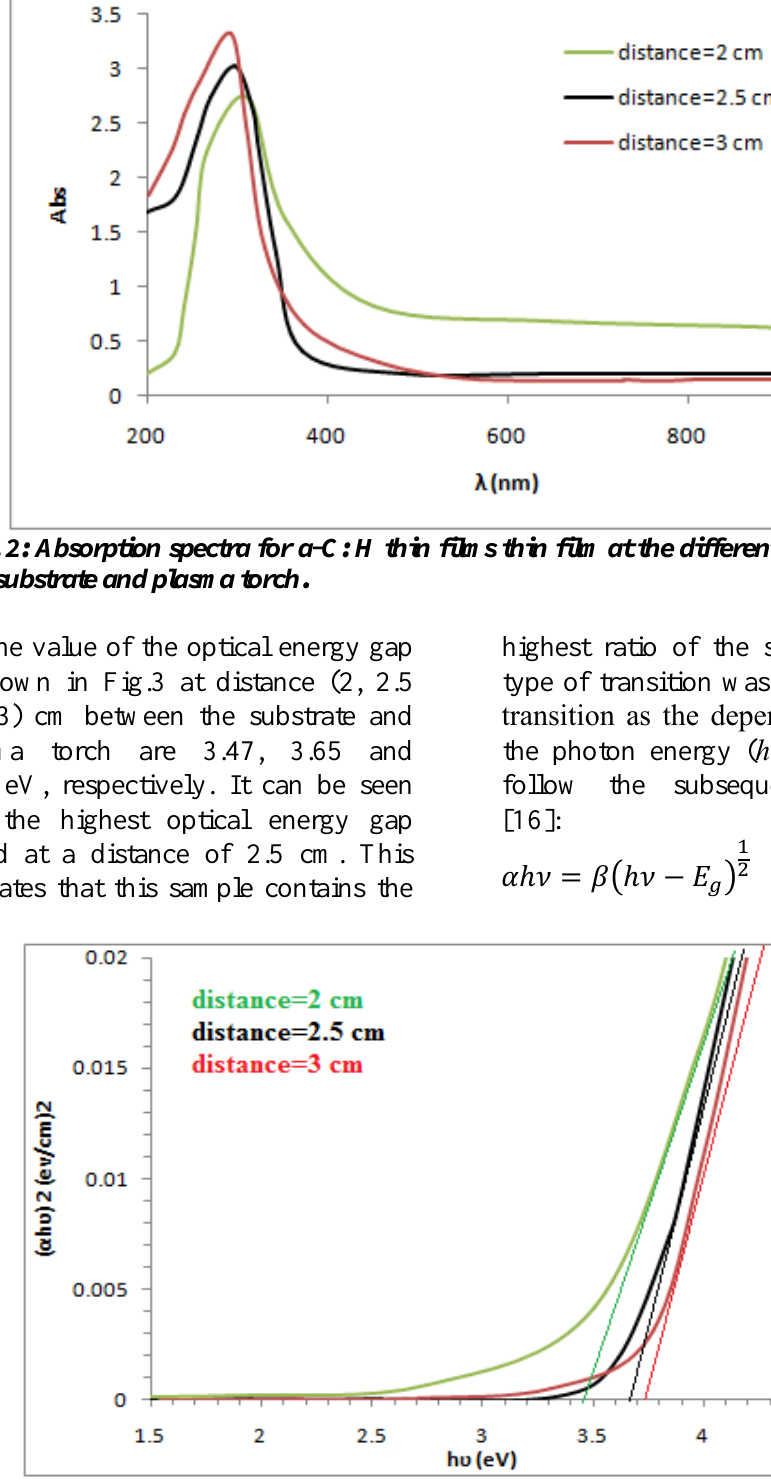
Fig.3: The variation of (αhʋ) 2 versus the Photon Energy (hʋ) of a-C: H thin films thin film at the different distance between the substrate and plasma